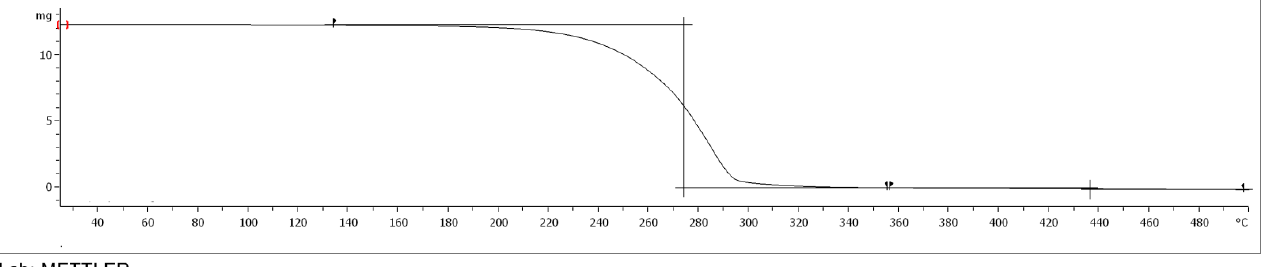
Figure 5. TGA curve of DOP.